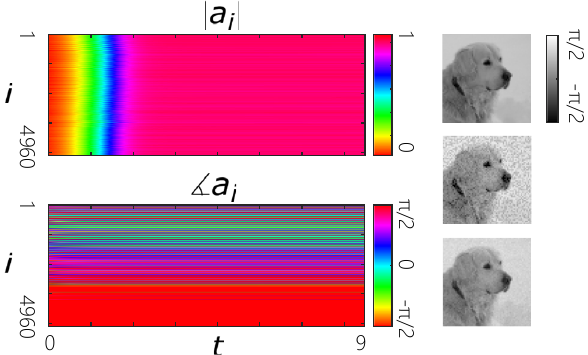
Figure 5: An exemplary simulation of the network described in Figure 4 under frequency and linewidth detuning of individual oscillators according to Eq. (9). Left: A raster plot of the dynamics of the amplitudes and phases of the oscillators. Right: Reconstruction of a perturbed image. Here, the normalized frequencies and decay rates of oscillators are randomly perturbed with random numbers drawn from a normal distribution with a standard deviation of 5 % of the decay rate of a single